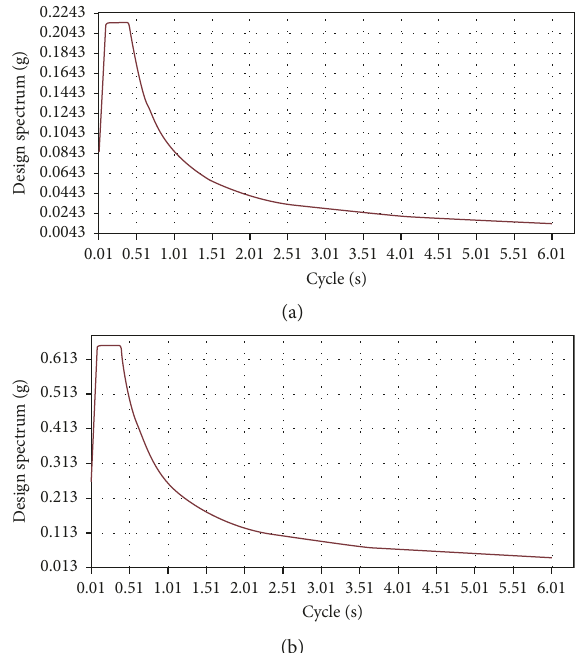
Figure 12: Three-dimensional cumulative mode participation rate: